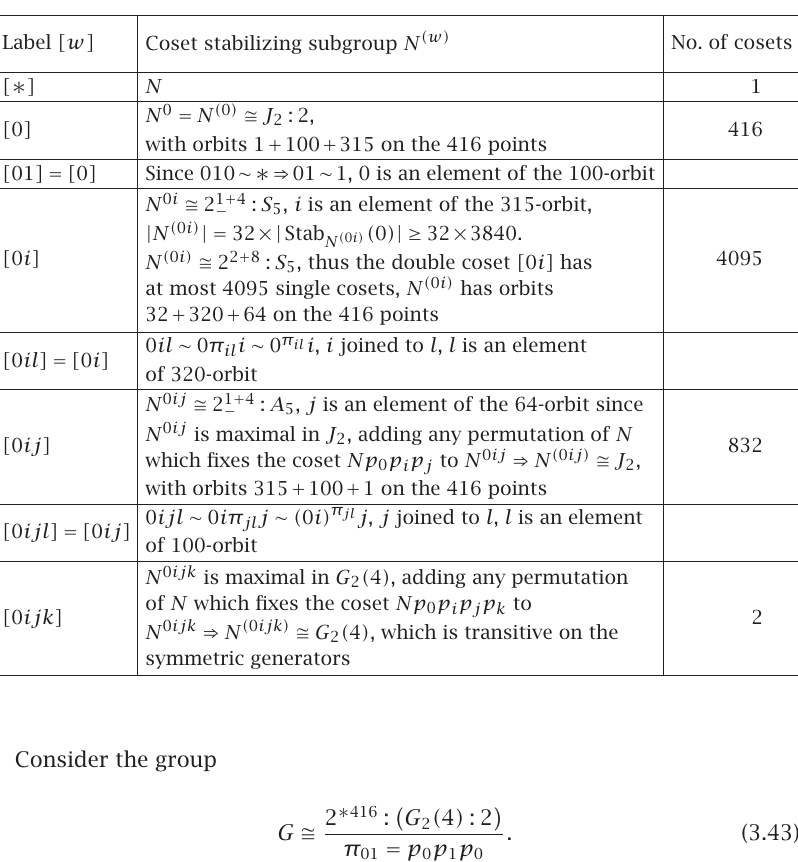
Table 3.4 . Double coset enumeration for 3 · Suz :